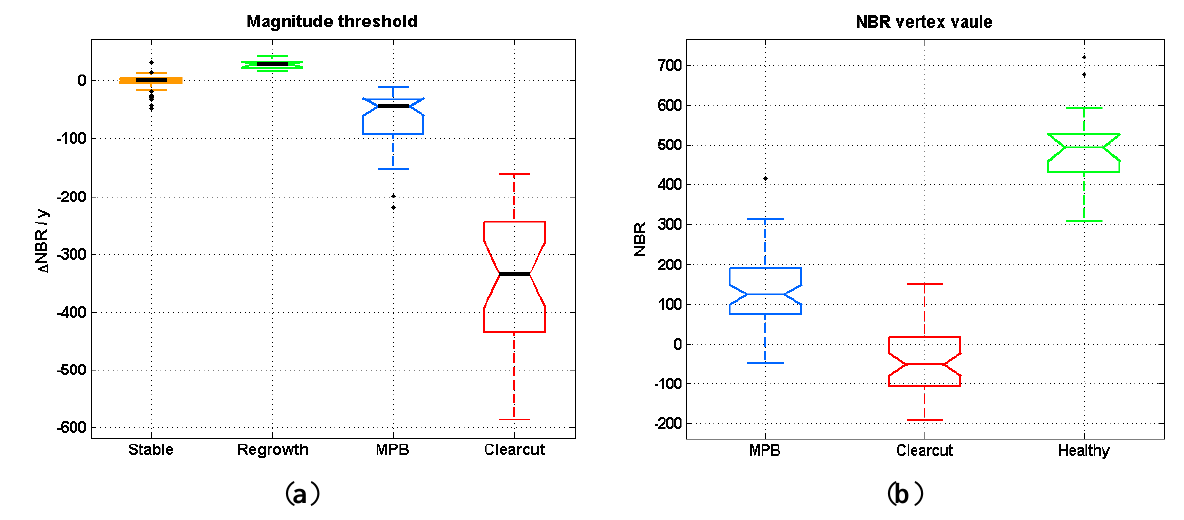
Figure 4. Tukey boxplot for ( a ) the averaged annual normalized burn ratio (NBR, multiplied by 100) changes of stable, regrowth, MPB mortality and clearcut plots; ( b ) current vertex values of post-MPB mortality, post-clearcut events and healthy plots. The bottom and top of the box are the first and third quartiles, and the band inside the box is the median. The whiskers represent the 1.5 interquartile range of the lower and upper quartile.